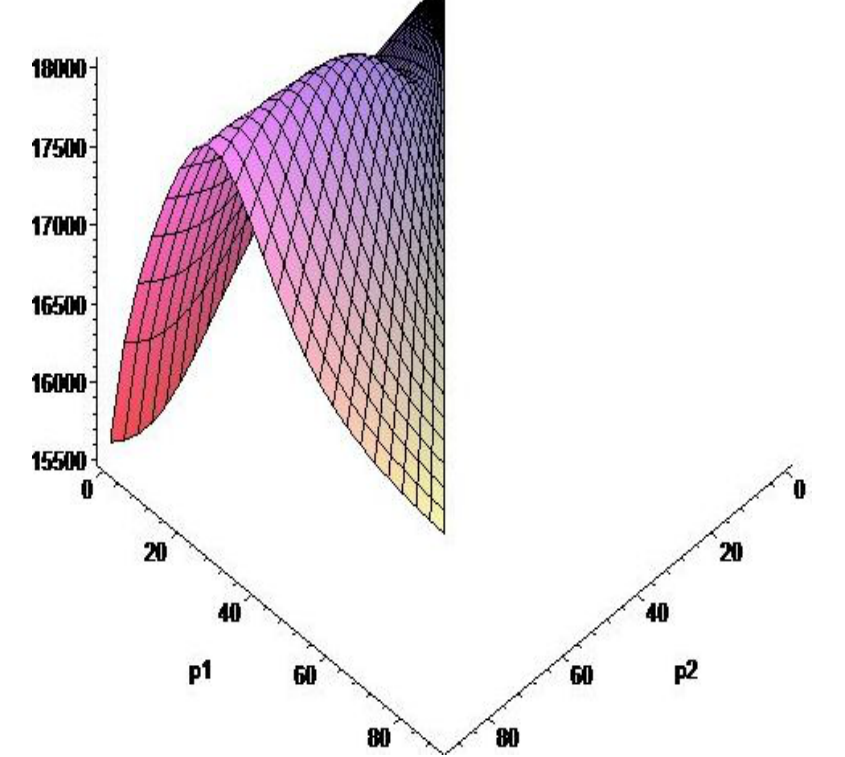
Figure 7. Surface (cid:101) J ( θ ) for the Ebola outbreak in Zaire (1976) for σ = 1 , ν = 1